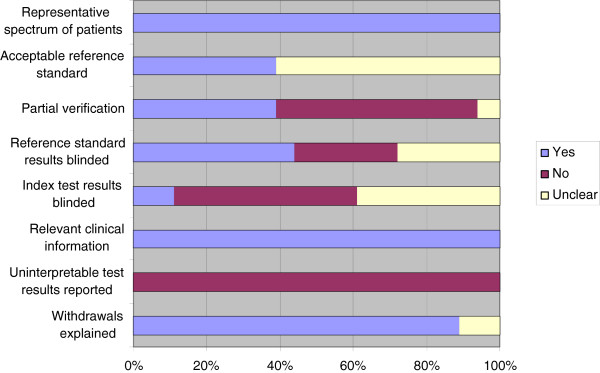
Quality assessment. Quality assessment of individual QUADAS items presented as percentages across all included studies.